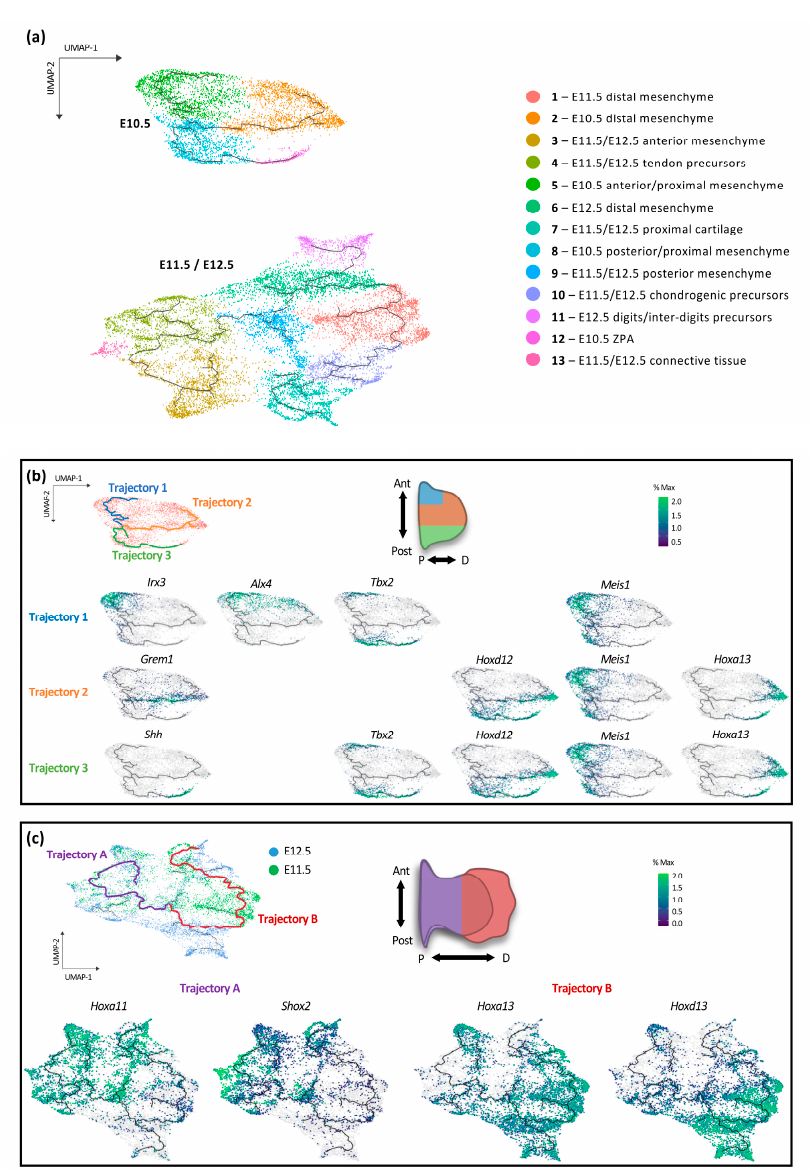
Figure 2. Characterization of the main transcriptional trajectories in the developing limb mesenchyme. ( a ) UMAP visualization of the forelimb bud mesenchymal cells colored according to cluster identity on which developmental trajectories, identified using Monocle 3, are represented. ( b ) Characterization of the three mesenchymal trajectories at E10.5, trajectory 1 is highlighted in blue, trajectory 2 in orange and trajectory 3 in green on the UMAP representation (top left). The E10.5 forelimb bud schematic indicates the orientation of the UMAP representation and the localization of the trajectories (middle top). Expression profiles of marker genes for each trajectory are shown below. Color scale indicated the scaled expression to percent of the maximum expression of all marker genes at E10.5 (top right). ( c ) Identification of the two main transcriptional trajectories at E11.5 (green cells) and E12.5 (blue cells), trajectory A is highlighted in purple and trajectory B in red (top left). E11.5 and E12.5 overlapping limb bud schematics indicate the orientation of the UMAP representation and the localization of the trajectories (middle top). Expression profiles of marker genes for each trajectory are shown below (bottom left and right, respectively). Color scale indicated the scaled expression to percent of the maximum expression of all marker genes at E11.5 and E12.5 (top right). Ant: anterior, Post: posterior, P: proximal, D: